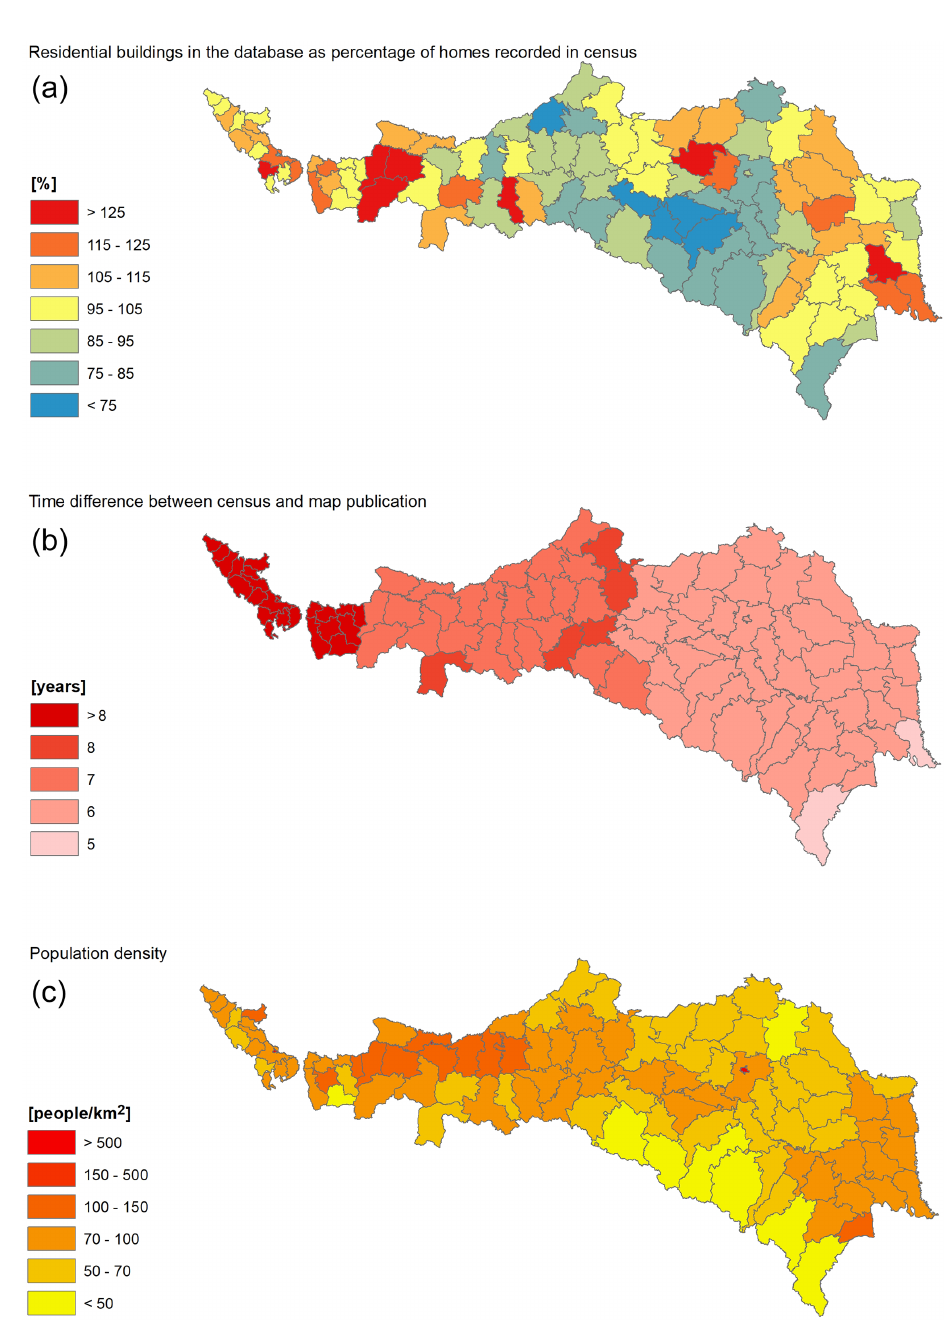
Figure B1. Uncertainty-related variables presented at the district level: residential buildings in the database as percentage of homes recorded in the census (a) , time difference between census and map publication (b) , and population density (c) .